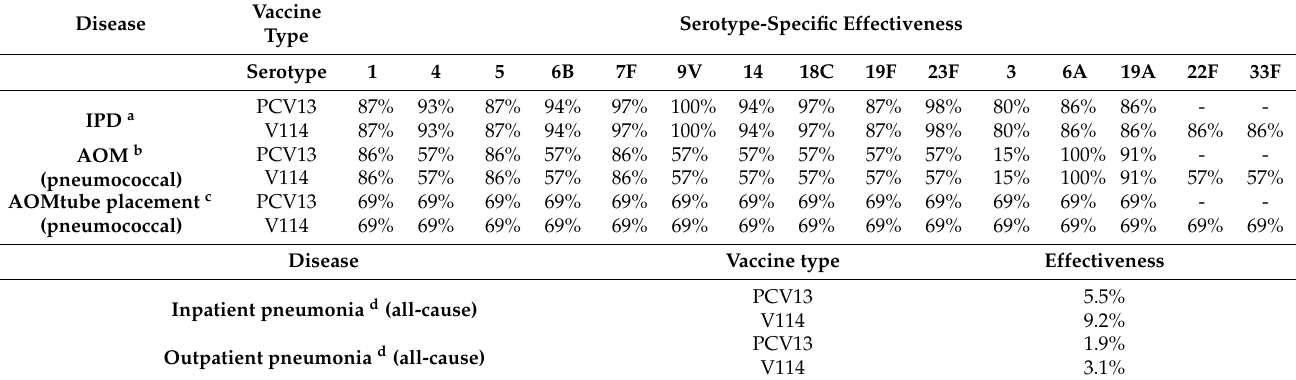
Table 2. Vaccine effectiveness of PCV13 and V114 in the base